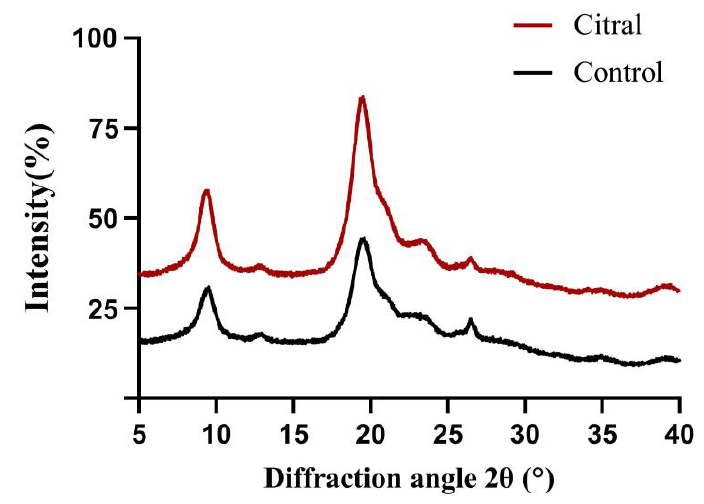
Figure 6. Comparison of X-ray powder diffractograms of the chitin of R. flaviceps in the control and citral-treated groups.